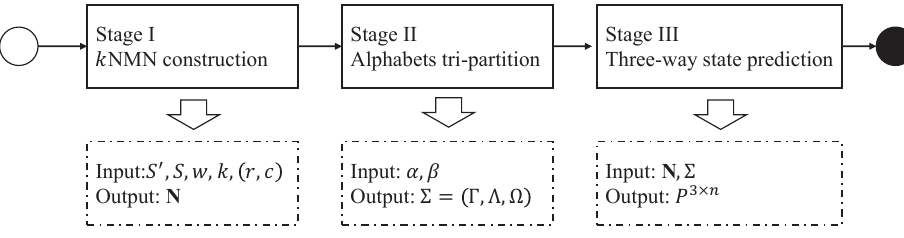
Figure 3. The process of the k NMN-3WSP